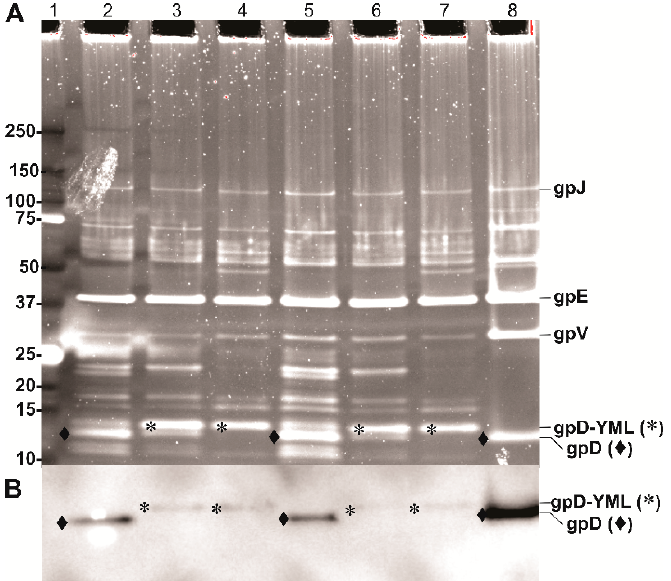
Figure 6. Display of gpD-YML epitope by λ cI 857 D am123 and λ imm 434 D am123 phages. Parallel, side by side protein electrophoresis runs of dialyzed CsCl-banded phage preps. ( A ) Oriole fluorescent gel stain (Bio-Rad) with UV light excitation and ( B) Western blot using primary anti-His-gpD mouse antibody (kindly provided by Dr. Philip Griebel, VIDO / Intervac, University of Saskatchewan) with chemiluminescence detection of the secondary rabbit anti-mouse IgG (HRP conjugated). Lanes for A and B : Lane 1: 1 µ L of Bio-Rad Precision Plus Protein Standards (10 Kd to 250 kDa). Lanes 2 and 5: